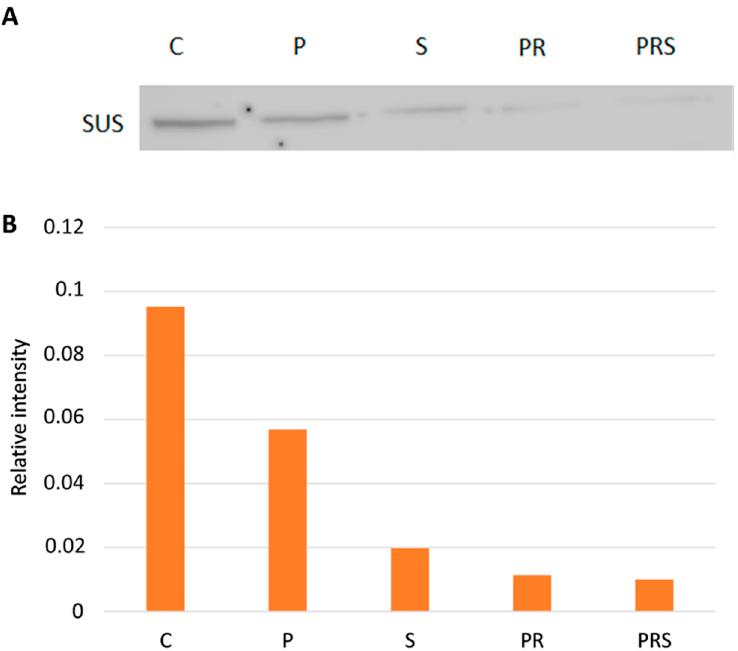
Figure 5. Immunoblotting with anti-Sus antibody: ( A ) Detection of Sus in different pollen samples. Lane 1, control sample (C); Lane 2, primed sample (P); Lane 3, stressed sample (S); Lane 4, primed and recovered sample (PR); Lane 5, primed, recovered and stressed sample (PRS). A total of 30 µ g of proteins was loaded in each lane; ( B ) measurement of Sus immunoblot intensity. The relative content of Sus was normalized against the content of actin, considered as a reference protein.